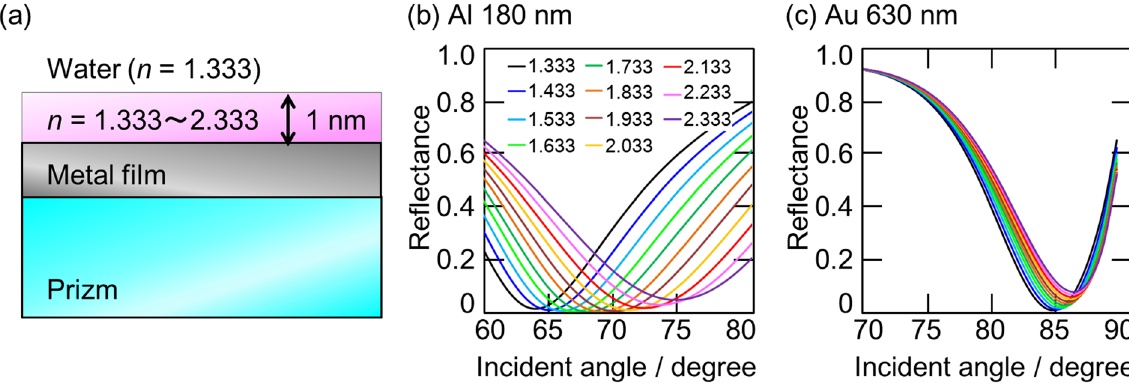
Figure 4. ( a ) A simulation model and ( b , c ) calculated incident angle dependence of ( a ) a 15 nm thick Al film on a sapphire prism at 180 nm wavelength and ( b ) a 40 nm thick Au film on a quartz prism at 630 nm wavelength with varying refractive indices from 1.333 to 2.333 in the thickness region of 1 nm on the metal